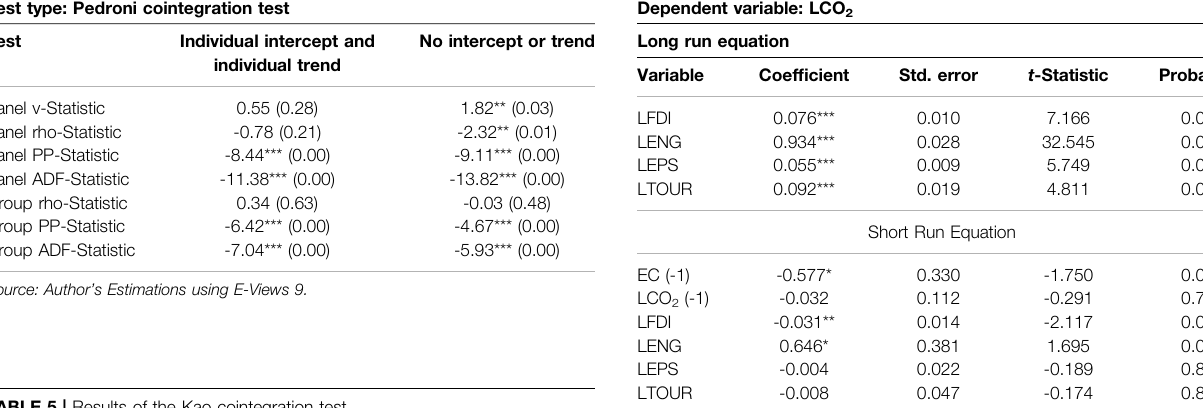
TABLE 5 | Results of the Kao cointegration test.